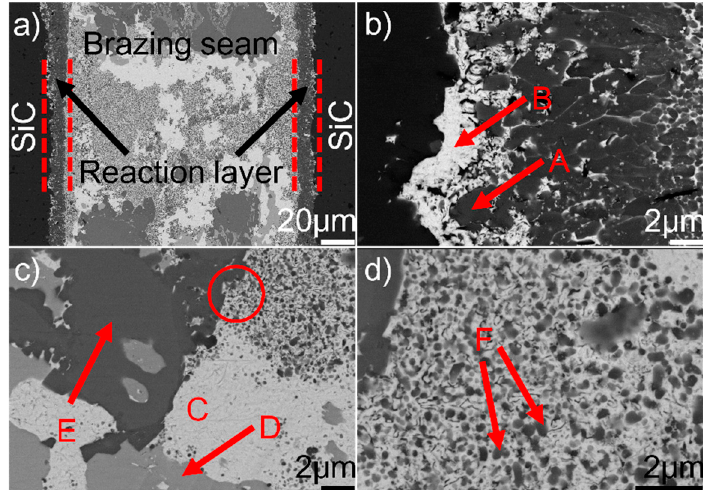
Figure 1. ( a ) Back-scattered electron (BSE) micrographs of the typical microstructure in the SiC/(Au 79 Ni 17 Pd 4 ) 96 Ti 4 /SiC joint brazed at 1523 K for 10 min; ( b ) magnified morphology of the SiC/braze interface; ( c ) magnified morphology of the typical braze zone; ( d ) magnified morphology of red cycle in ( c ).